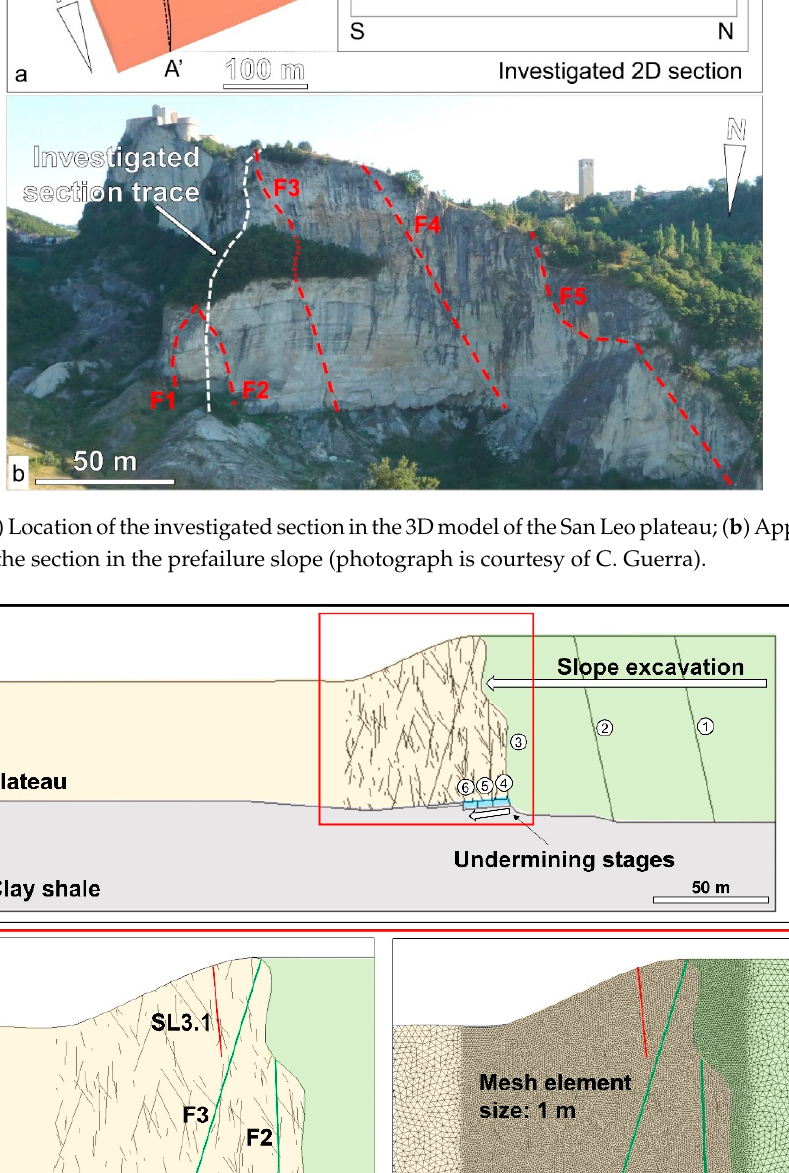
Geosciences 2019 , 9 , x FOR PEER REVIEW 14 of 31